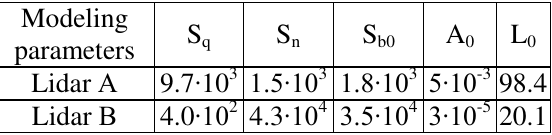
Table 2. Modeling parameters of Lidars A and B. Fig. 1. Lidar modeling: Block diagram of relationships between system parameters.